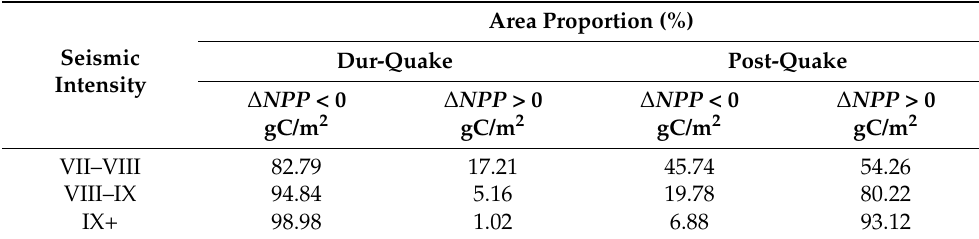
Table 4. The ∆ NPP area proportion corresponding to three seismic intensities one month before and after the